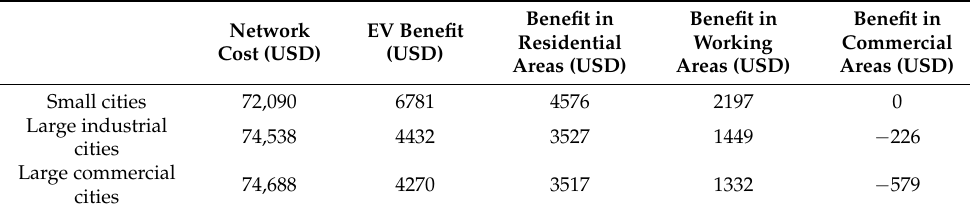
Table 4. Costs of the distribution network and benefits of electric vehicles in different functional areas.